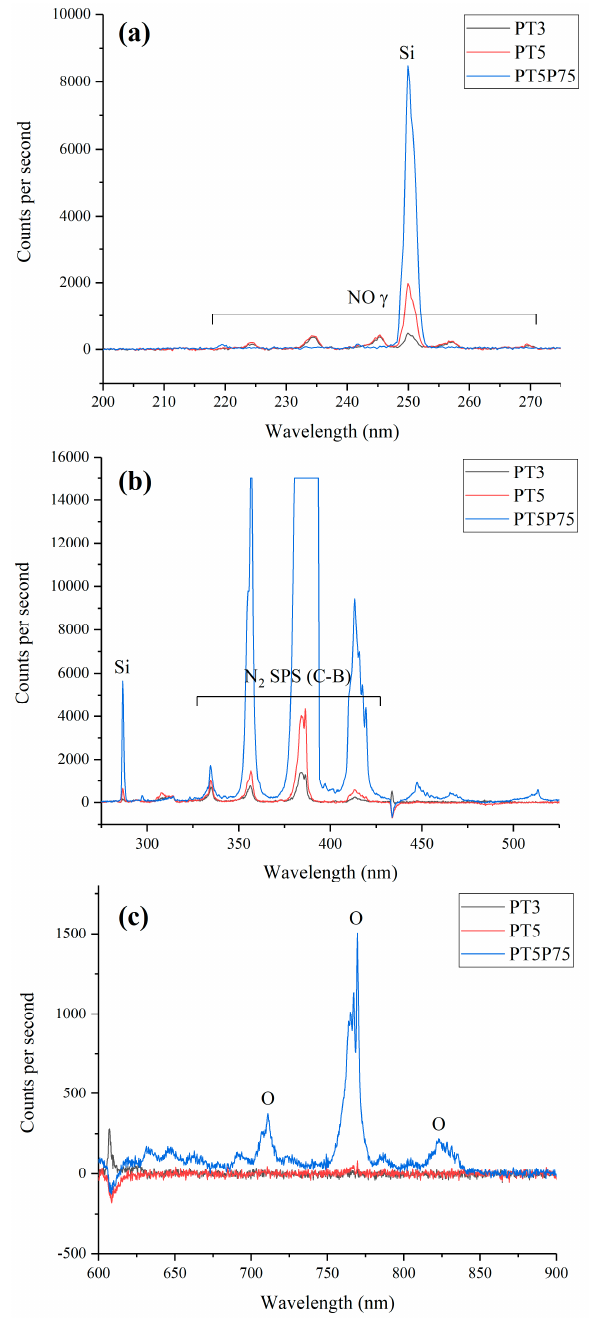
Figure 7. Optical emission spectra from PT3, PT5, and PT5P75 conditions. Three ranges of wavelength are chosen to highlight some of the differences. ( a ) 200–275 nm, ( b ) 275–525 nm, and ( c ) 600–900 nm.